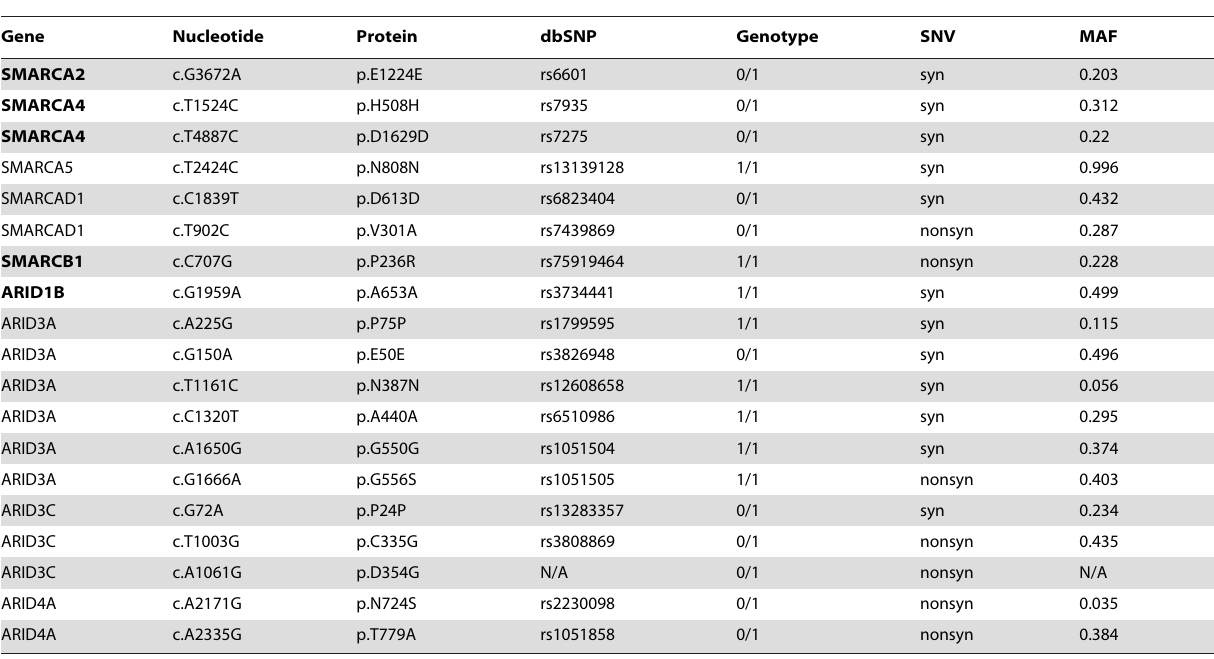
Table 1. SNPs revealed by exome sequencing in chromatin remodeling genes of the index patient.